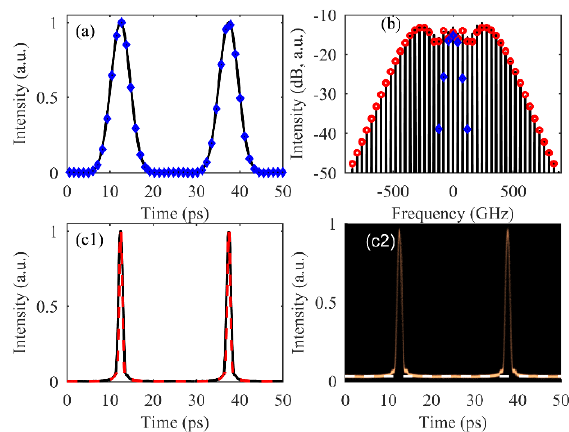
Fig. 2. (a) Temporal intensity profiles recorded on the optical sampling oscilloscope after the first linear shaping (solid line) are compared with the theoretical shape of the besselon (blue diamonds). (b) Optical spectrum after modulation (blue diamonds) and after nonlinear propagation (black lines). Results of numerical simulations are plotted with red circles. (c1) Temporal intensity profiles after the nonlinear propagation and quadratic spectral phase. Results of numerical simulation (red dashed line) are compared with experimental results (black line). Panel (c2) is similar to (c1) but recorded in the persistent mode of the optical sampling oscilloscope.